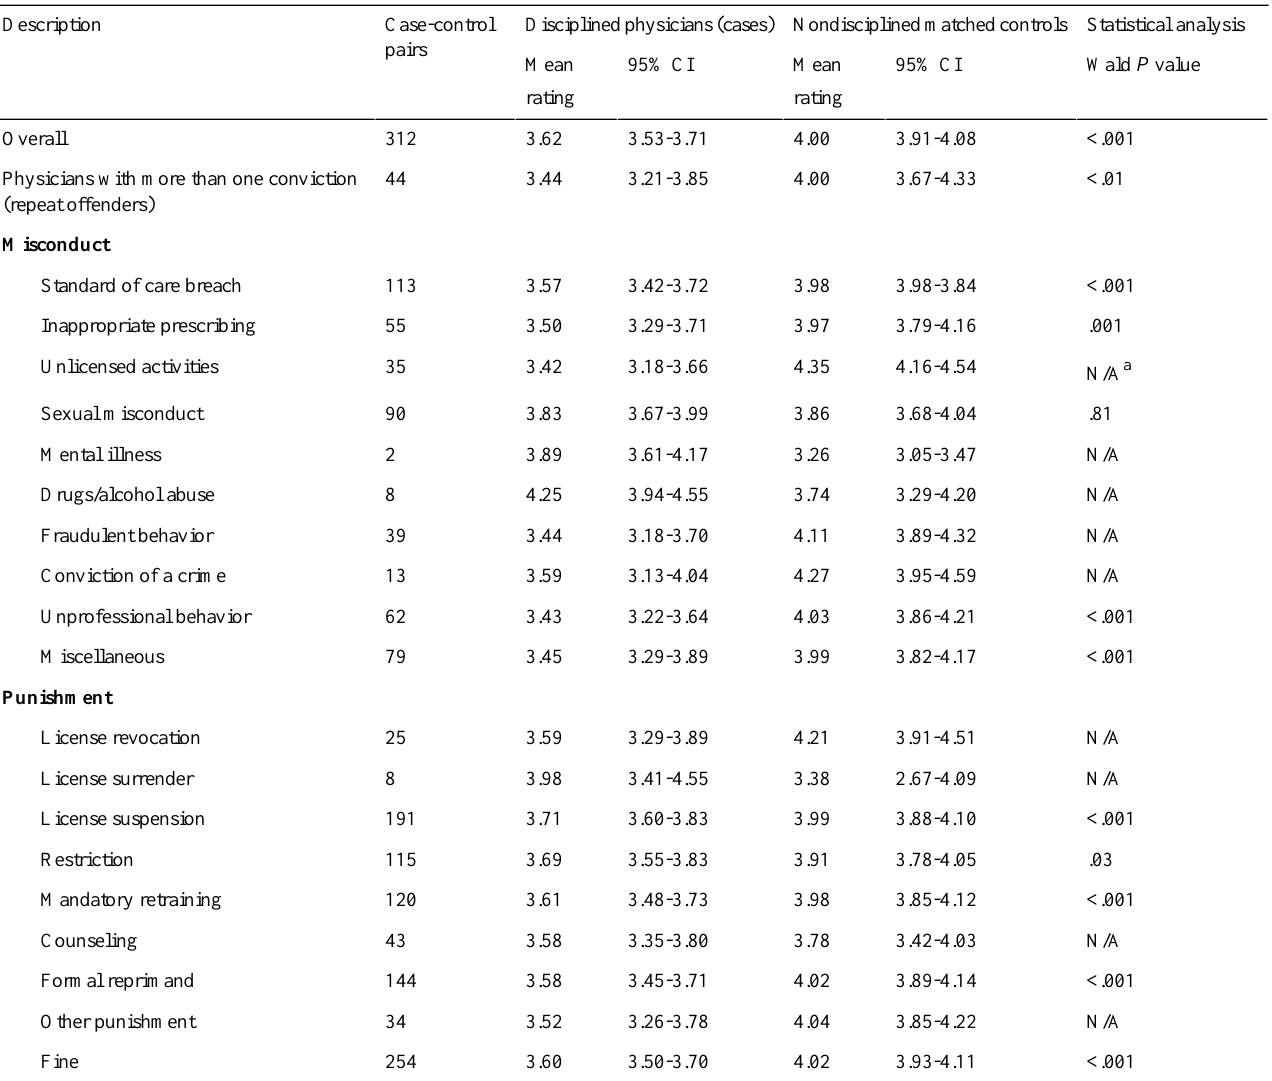
Table 2. Mean web-based physician ratings of disciplined physicians (2000-2013) and nondisciplined controls (2000-2013) by the type of misconduct and